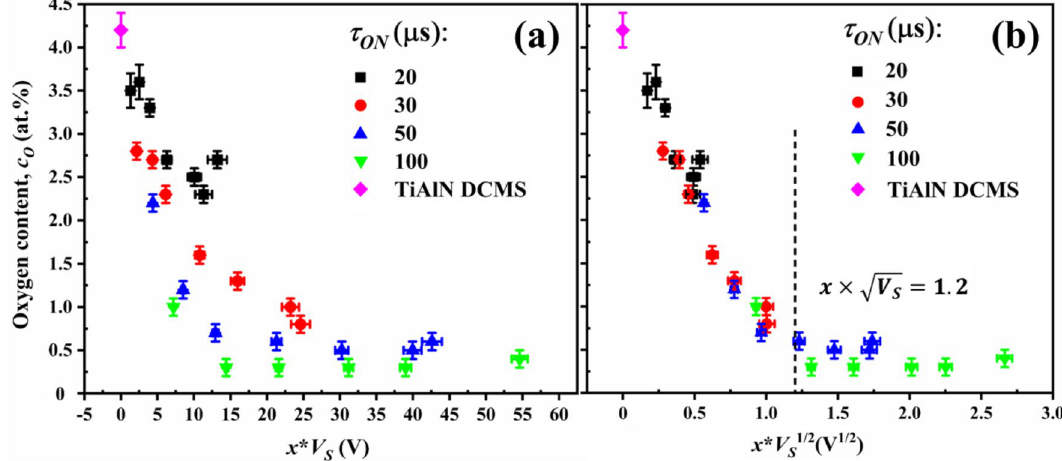
Figure 1. The ToF-ERDA-derived oxygen concentrations c o for (Ti 1- y Al y ) 1- x W x N films grown with the HiPIMS pulse length τ ON = 20 ( x = 0.02), 30 ( x = 0.04), 50 ( x = 0.07), and 100 μs ( x = 0.12) as a function of ( a ) x √ V s ( b ) x ×